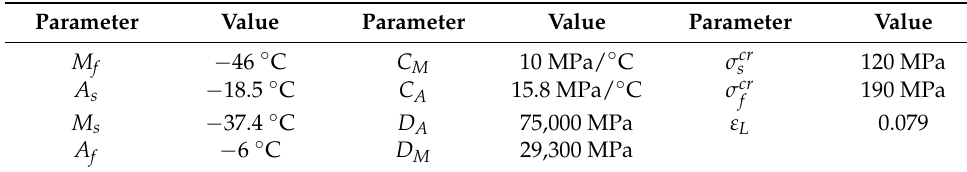
Table 2. Physical parameters of SMA